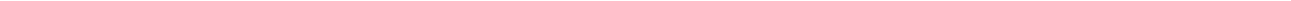
Figure 4 | Hypersensitivity in antephase protects genome stability. ( a ) Representative images from time-lapse movies of RPE CCNB YFP –53BP1 mCherry cells following 1Gy IR. Stills are representative of three independent experiments. Star indicates tracked daughter cell after mitosis. Time, hh:mm. Scale bars, 10 m m. ( b ) Progression into a subsequent cell cycle scored in cells that had degraded Cyclin B1 after 1Gy and cells that had recovered and